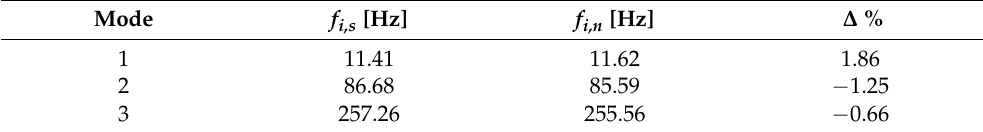
Table 6. Comparison between experimental eigenfrequencies of the cantilever beam and the corre- sponding numerical ones with the best value of the longitudinal elastic modulus E = 201 GPa.